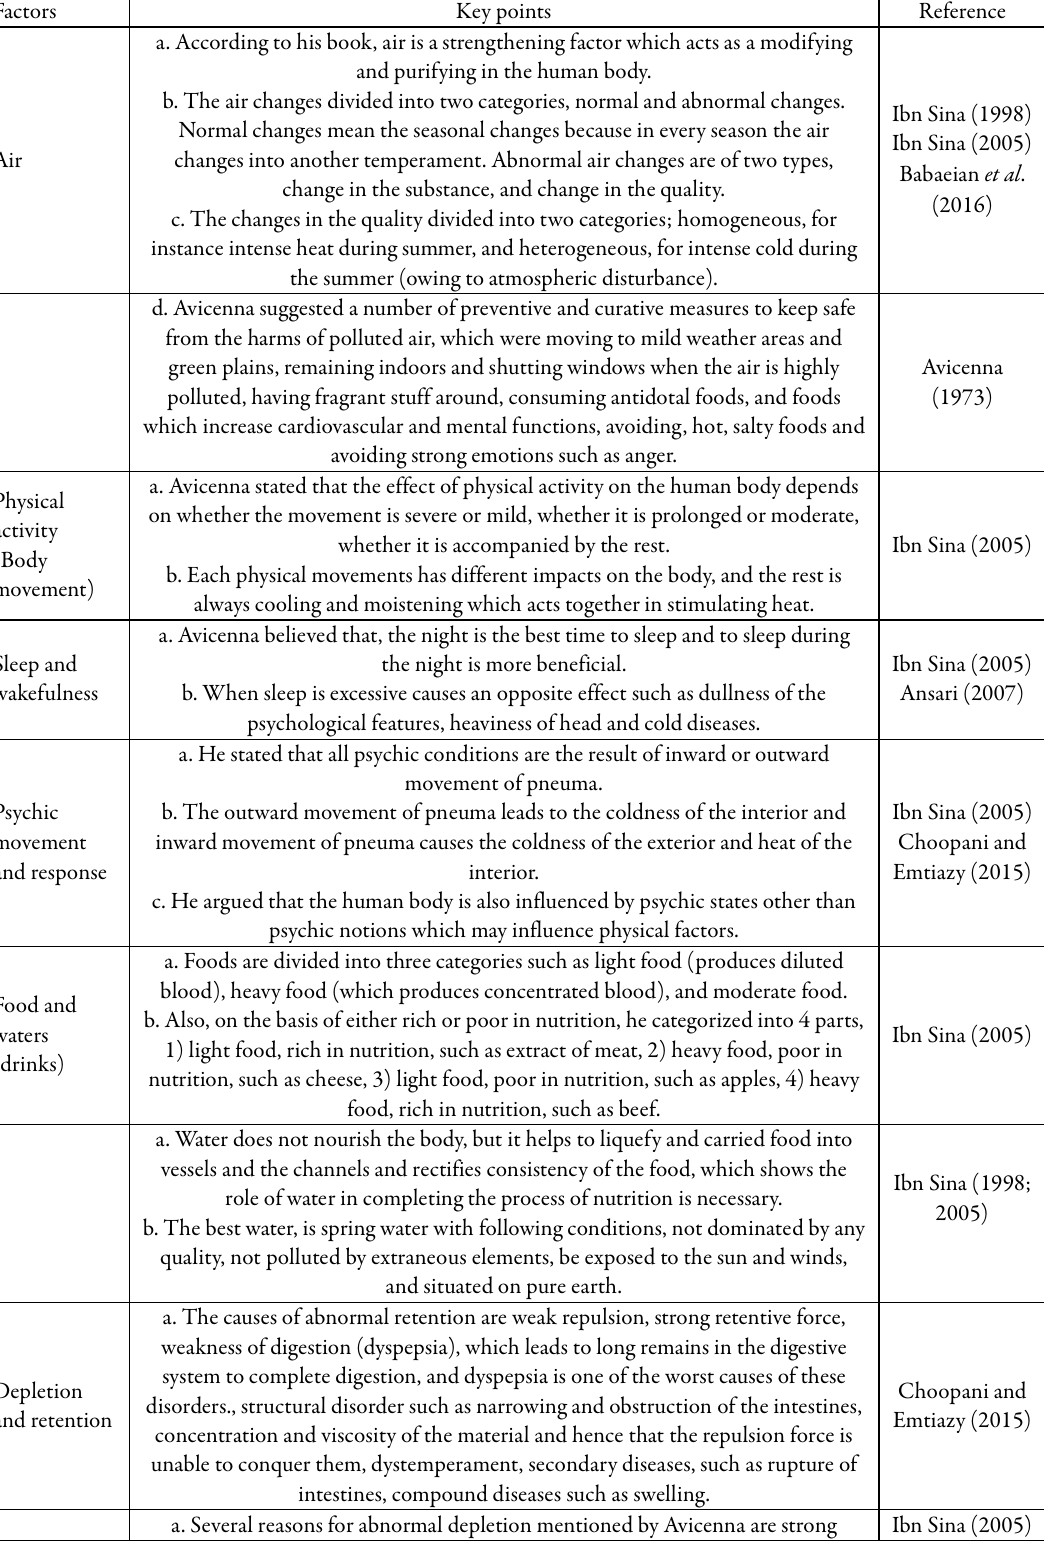
Table 3. Six essential lifestyle factors which were described by Avicenna